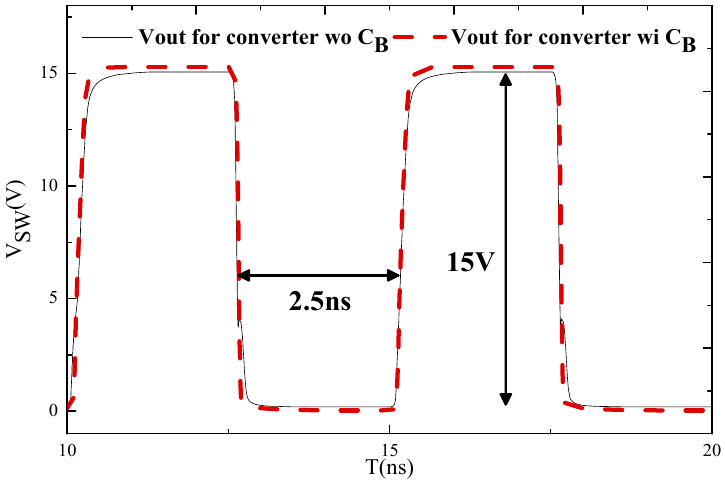
Figure 7. The simulated results for V SW of both converters: black solid line for the converter without C B and red dash line for the converter with C B.